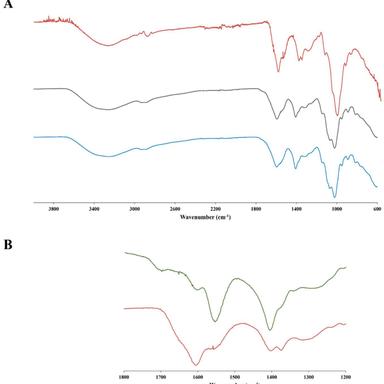
Panel A: FT-IR spectra of sodium hyaluronate in comparison to blank and loaded with sodium hyaluronate: sodium hyaluronate raw material (red), APC 111 (black), and APCH 111-2HH (blue). Panel B: Spectra in the wavelength range from 1800 to 1200 cm− 1 of sodium hyaluronate (red) and mathematical difference between normalized APC and APCH 111–2HH spectra (green). (For interpretation of the references to colour in this figure legend, the reader is referred to the web version of this article.)